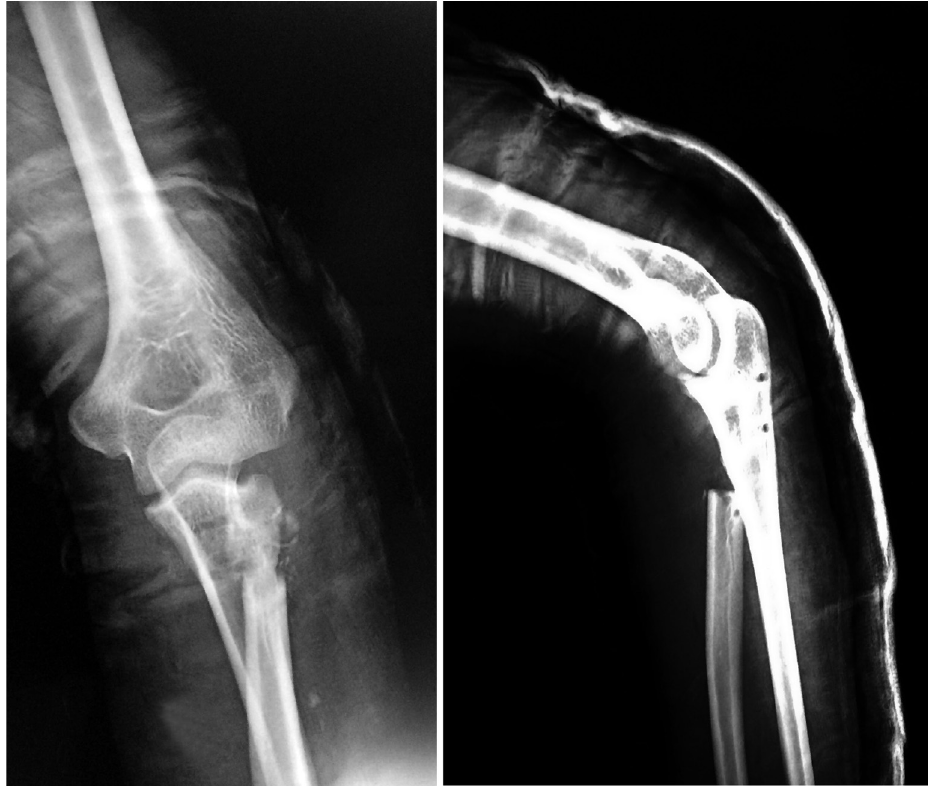
Figure 4. Postoperative radiograph after excision of radial head along with radial shaft up to the distal extent of synostosis. Drill holes seen near the osteotomized radius and ulna for securing the tensor fascia lata graft and muscles,